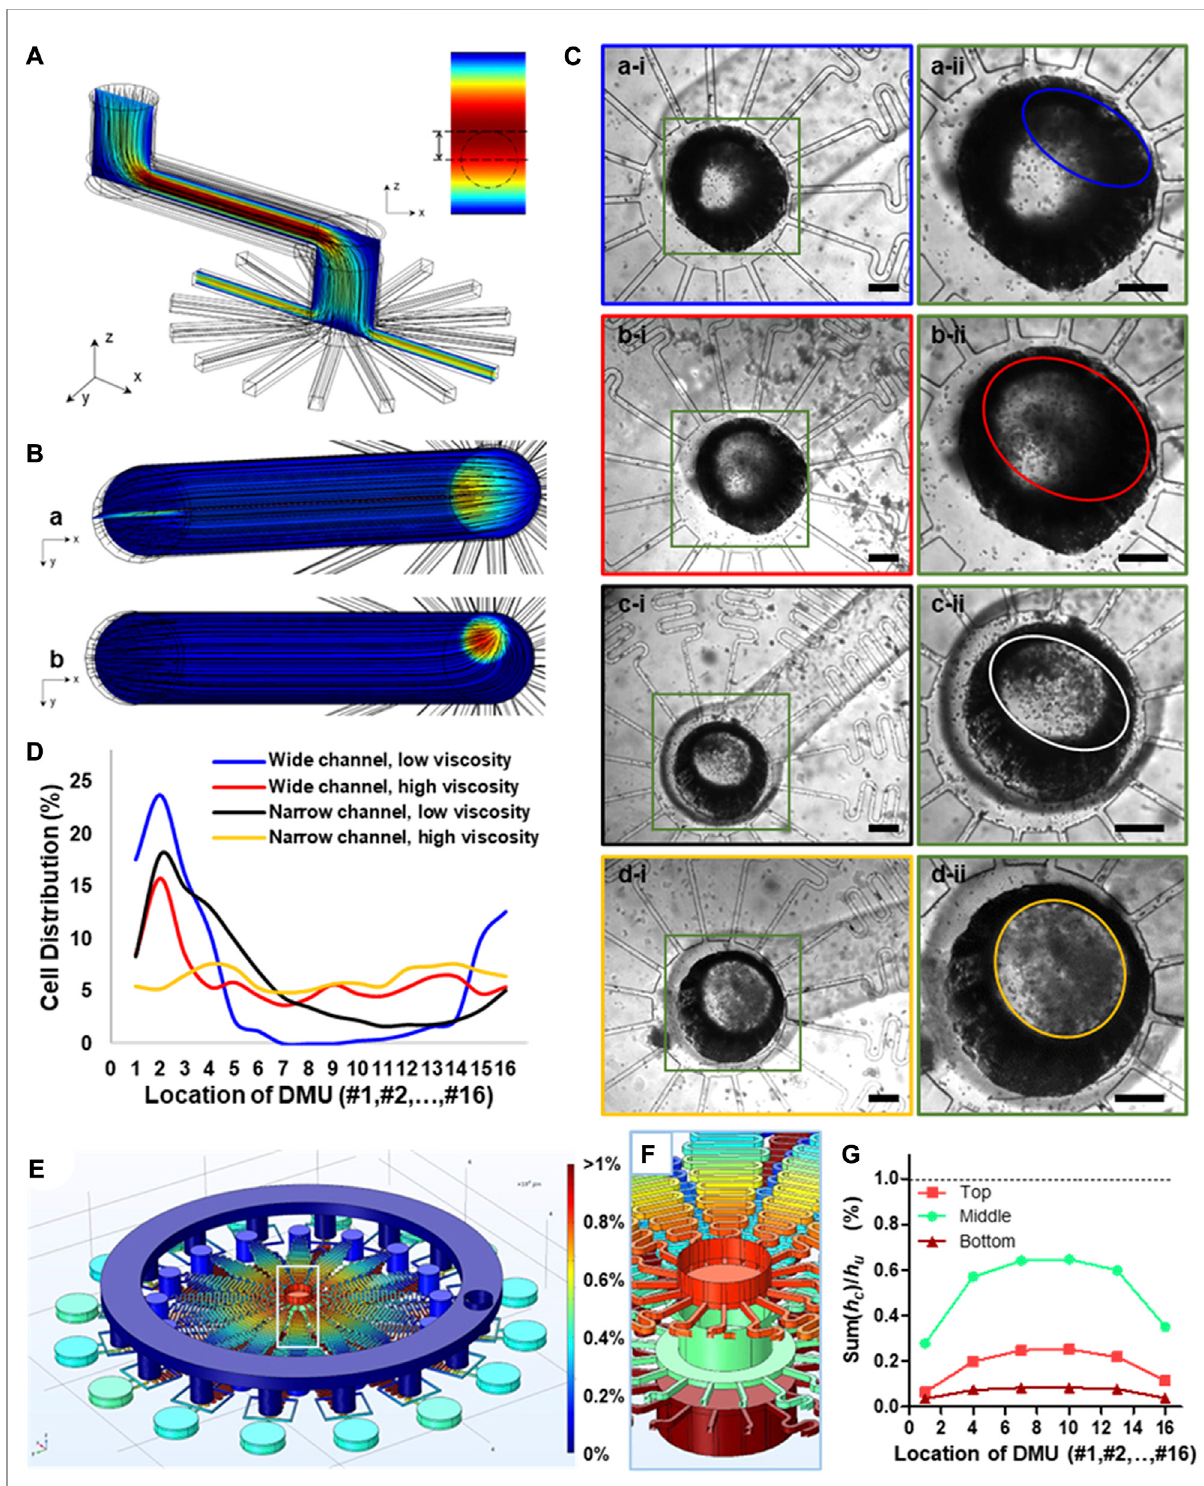
FIGURE 2 The prediction of movement state of microparticles within microchannels and the design of integrated micro fl uidic chip based on computational fl uid simulation by COMSOL Multiphysics. (A) 3D structure of the partial channel structure containing one wide and long microchannel with several turns and a distribution section with 16 parallelized channels within integrated chips to predict the movement state of microparticles. (B) The cross-section view of fl uid velocity distribution within microchannels with different channel sizes under the same fl ow